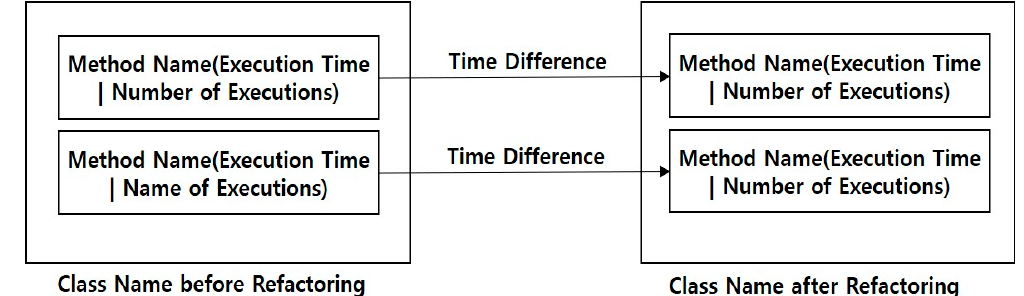
Figure 2. The class view.